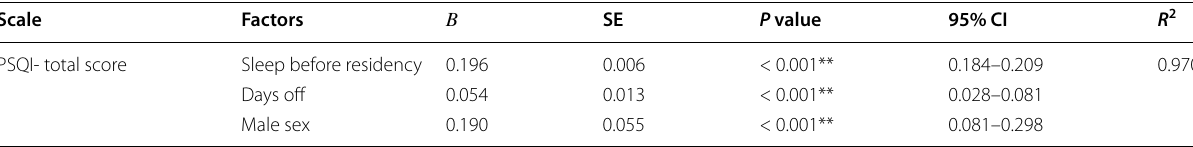
*indicates the presence of significance **indicates highly significance